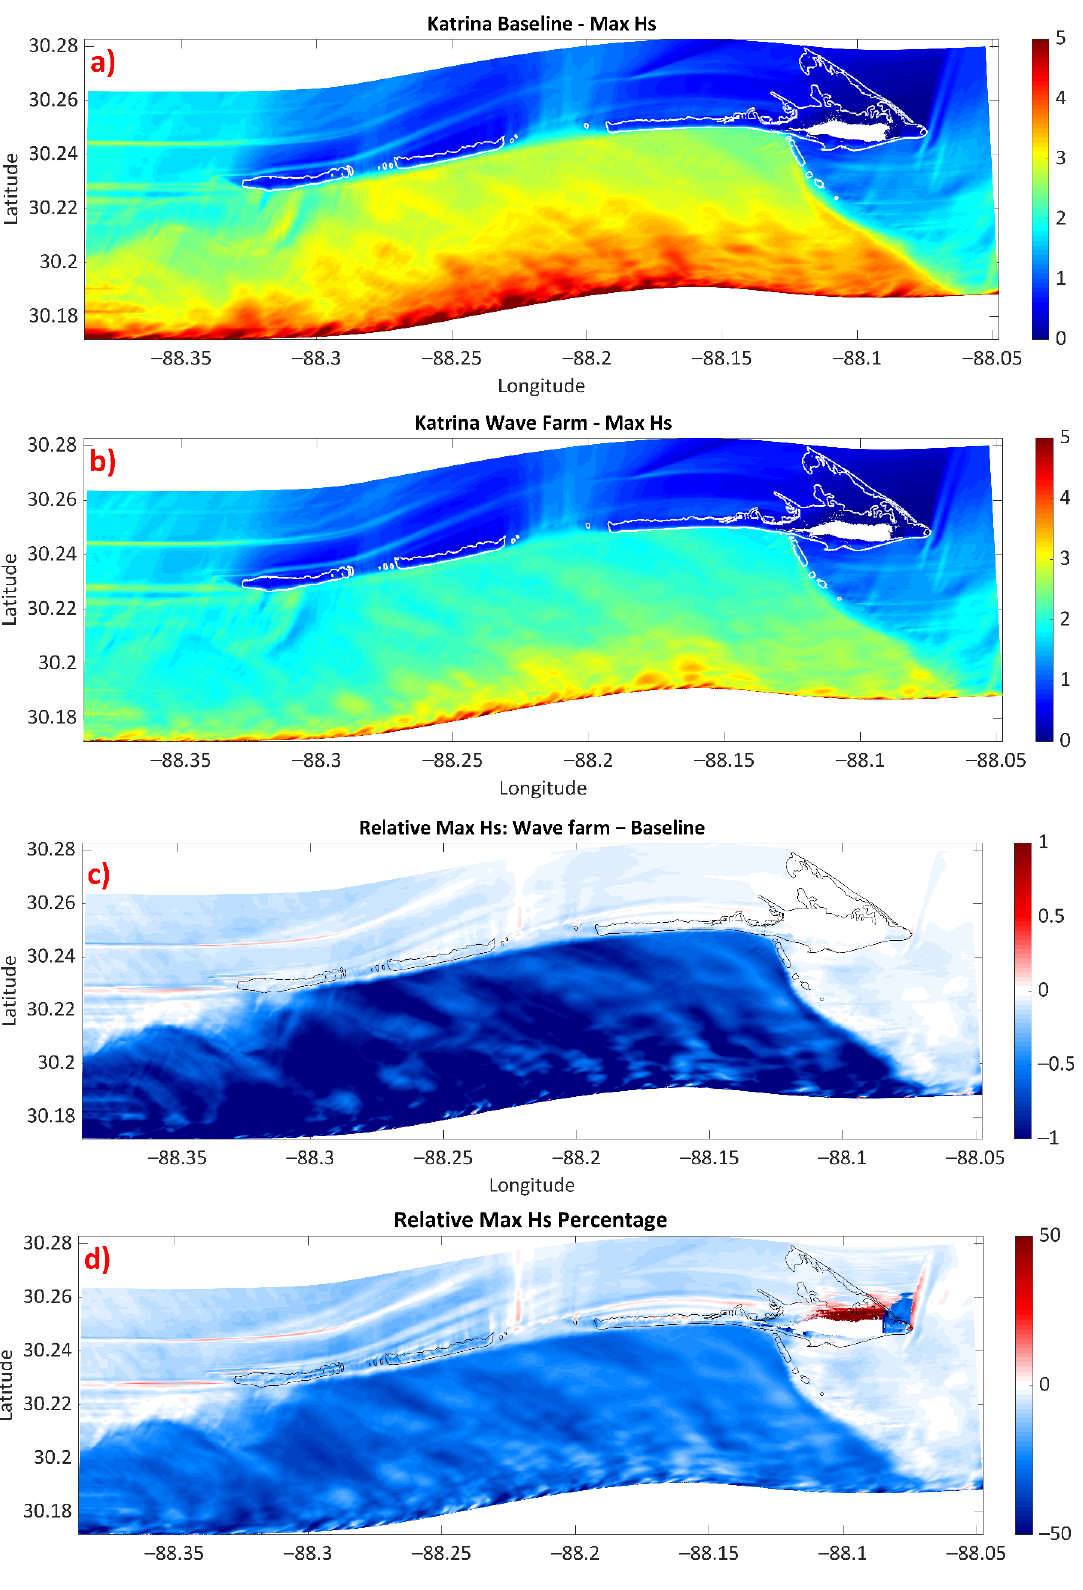
Figure 12. Maximum wave heights (Hs) across the domain of Dauphin Island, AL: ( a ) baseline scenario, ( b ) wave farm scenario. ( c ) Hs difference between the two scenarios in [m] Baseline values are subtracted from wave farm values. The blue color represents the reduction in Hs due to wave energy converter devices (WECs), and the red color represents the increase in Hs due to WECs. ( d ) Hs difference in [%].